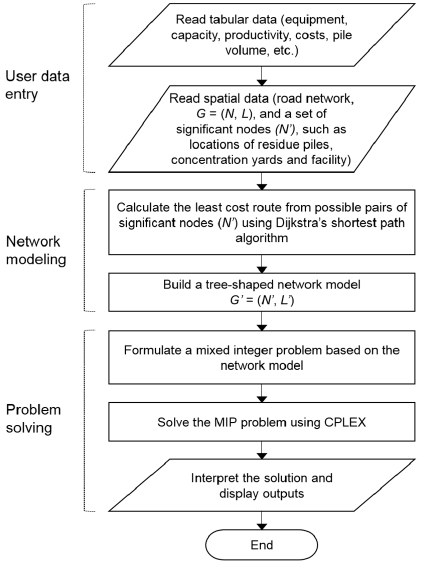
Figure 2. A flow chart diagram presenting three model components, required data and solution procedures used in the optimization model.